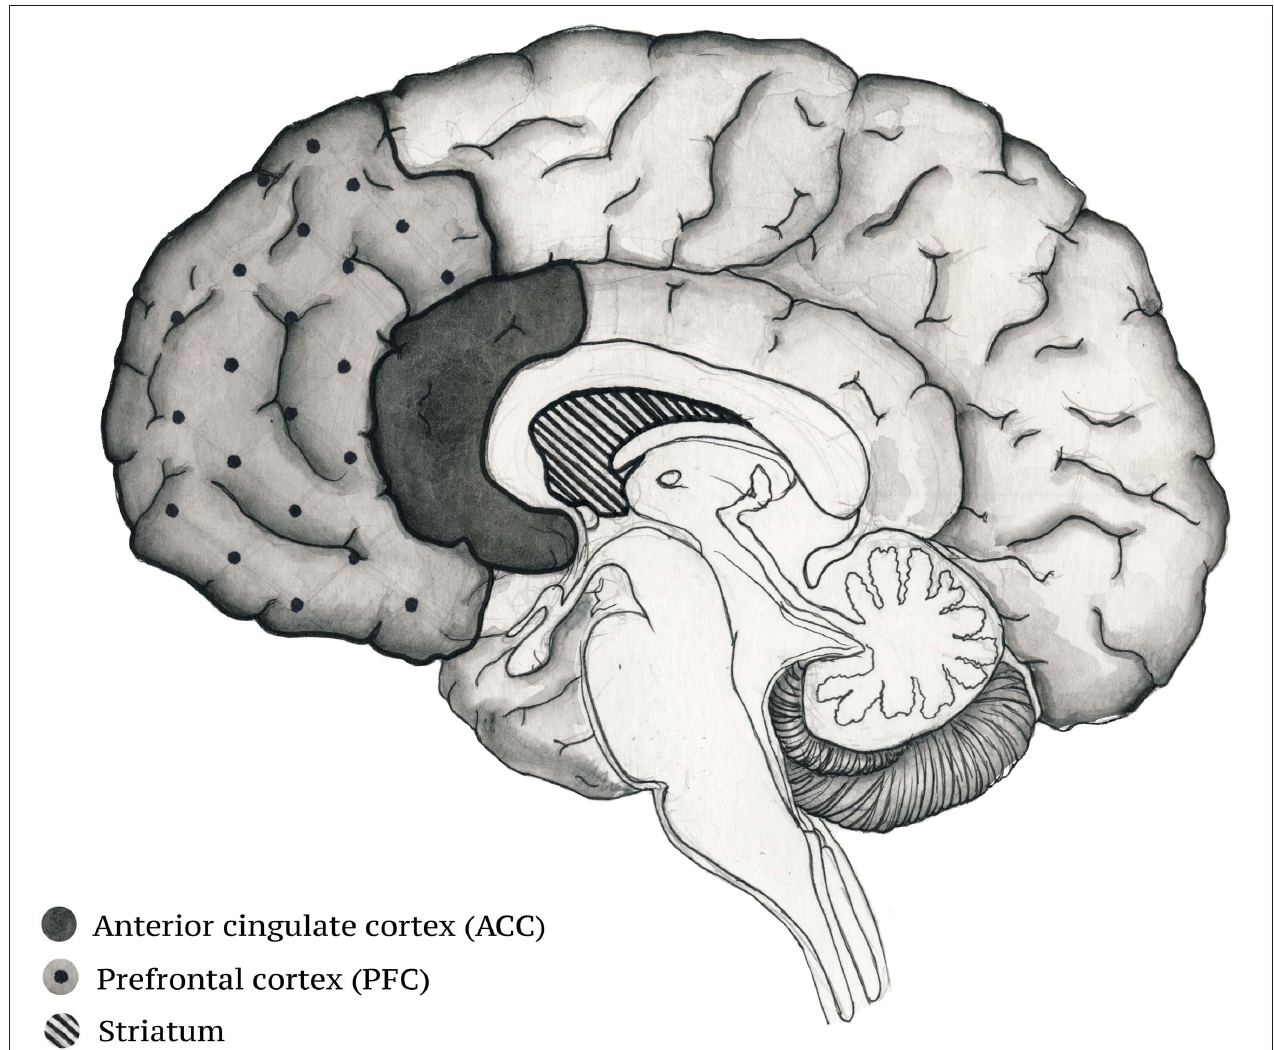
FIGURE 1 | Brain structures activated during musical experience that participate in the control of homeostatic regulation.